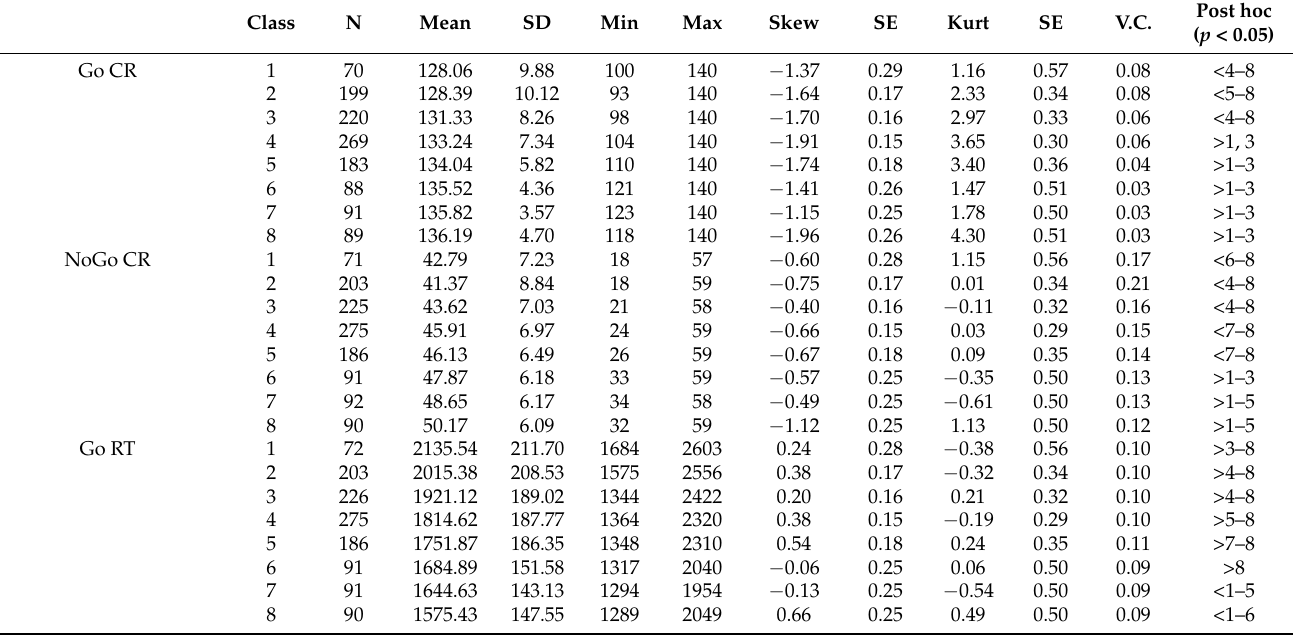
Table 1. Descriptive for each EF task by